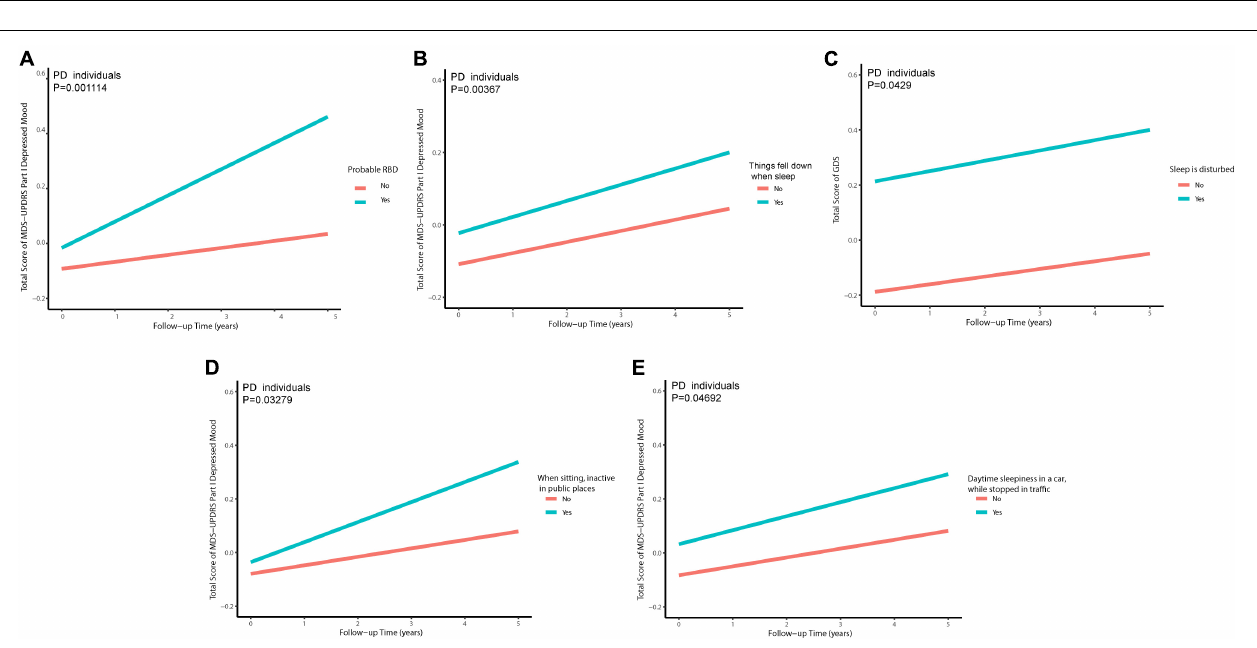
FIGURE 4 | Associations of sleep disorders with depression in longitudinal analyses.